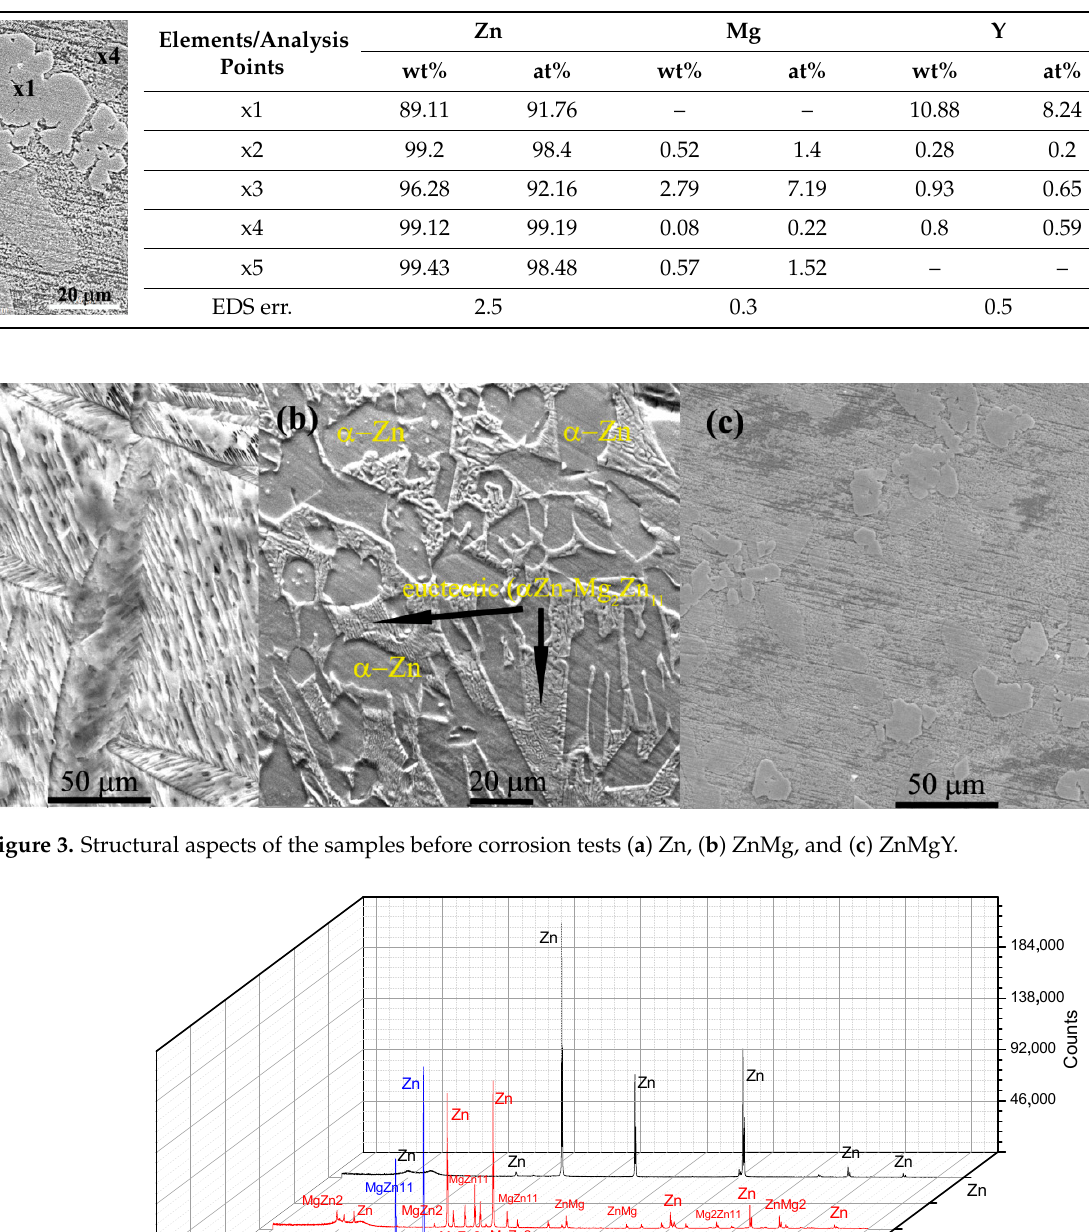
Table 1. Chemical composition analysis of structural elements of ZnMgY alloy (Zn3Mg0.6Y).